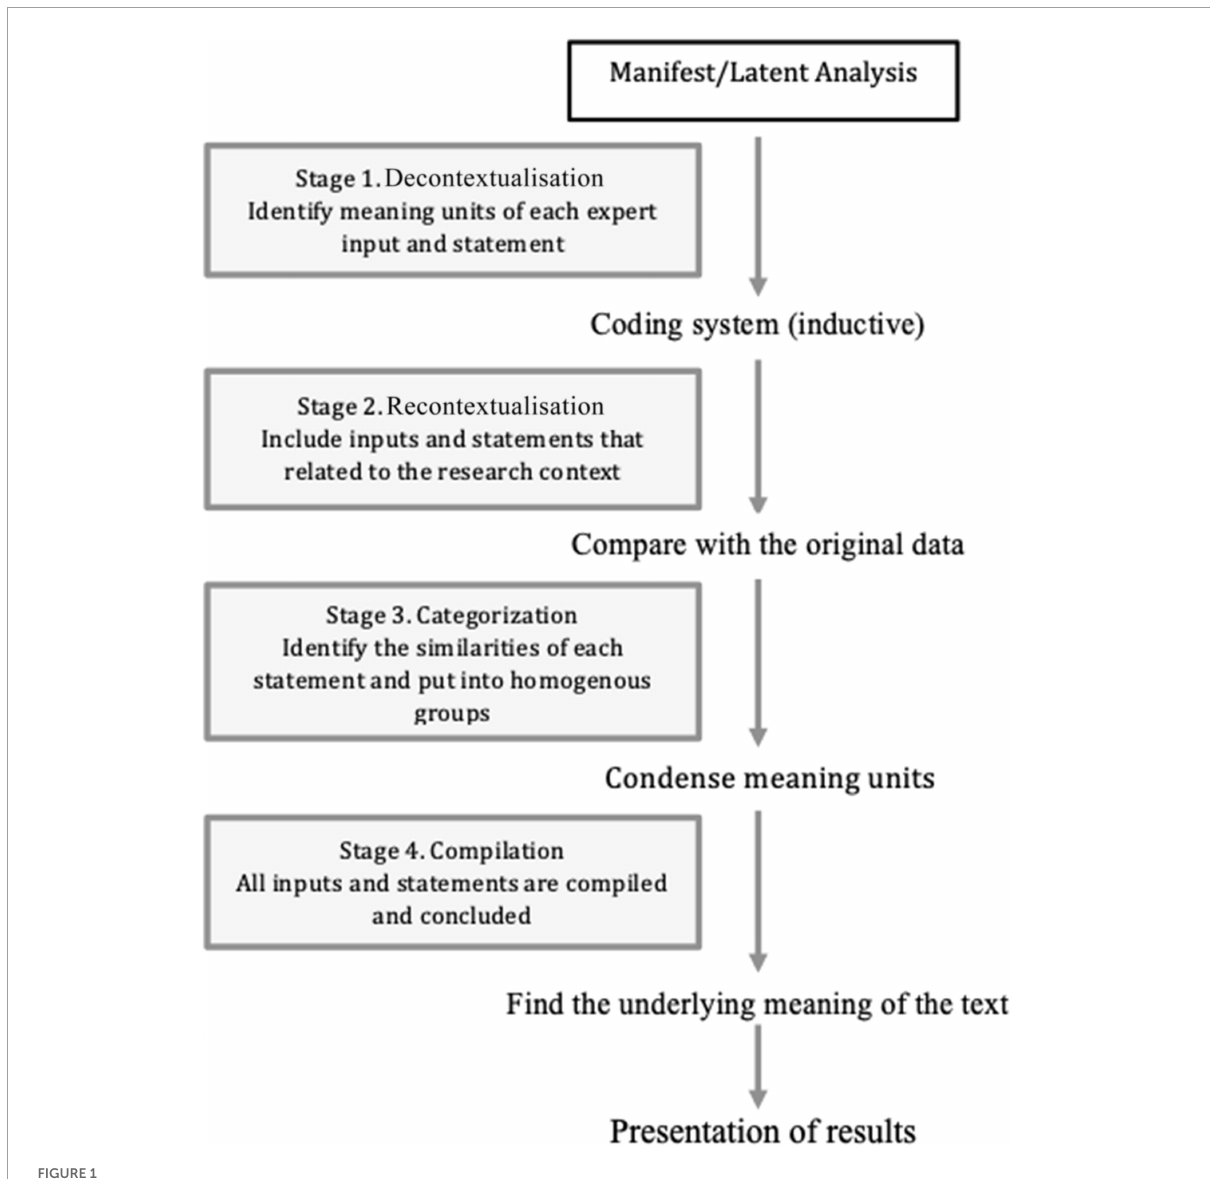
FIGURE1 Manifest/latent qualitative data analysis based on Bengtsson (30), p.